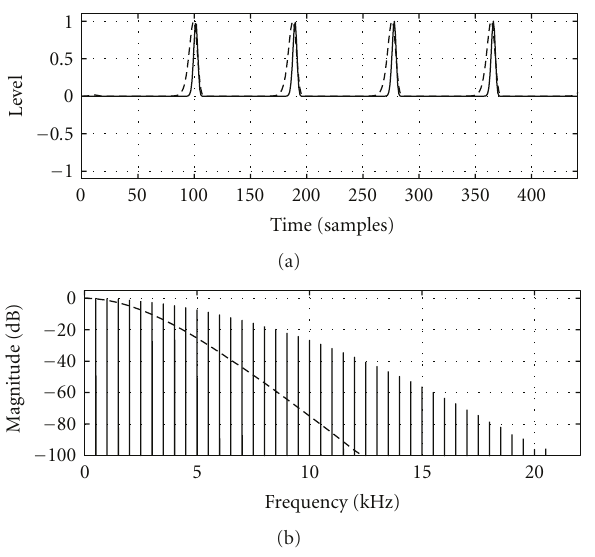
Figure 25: Waveform and spectrum of FBAM vocal timbre ( a :) with three formants ( f 0 =